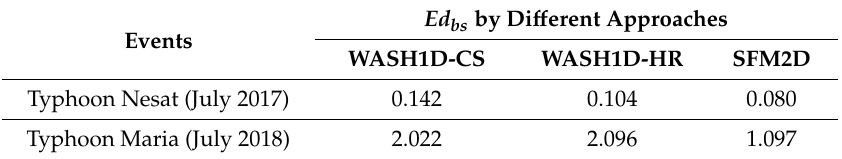
Table 6. Performance comparisons of three approaches for Typhoons Nesat and